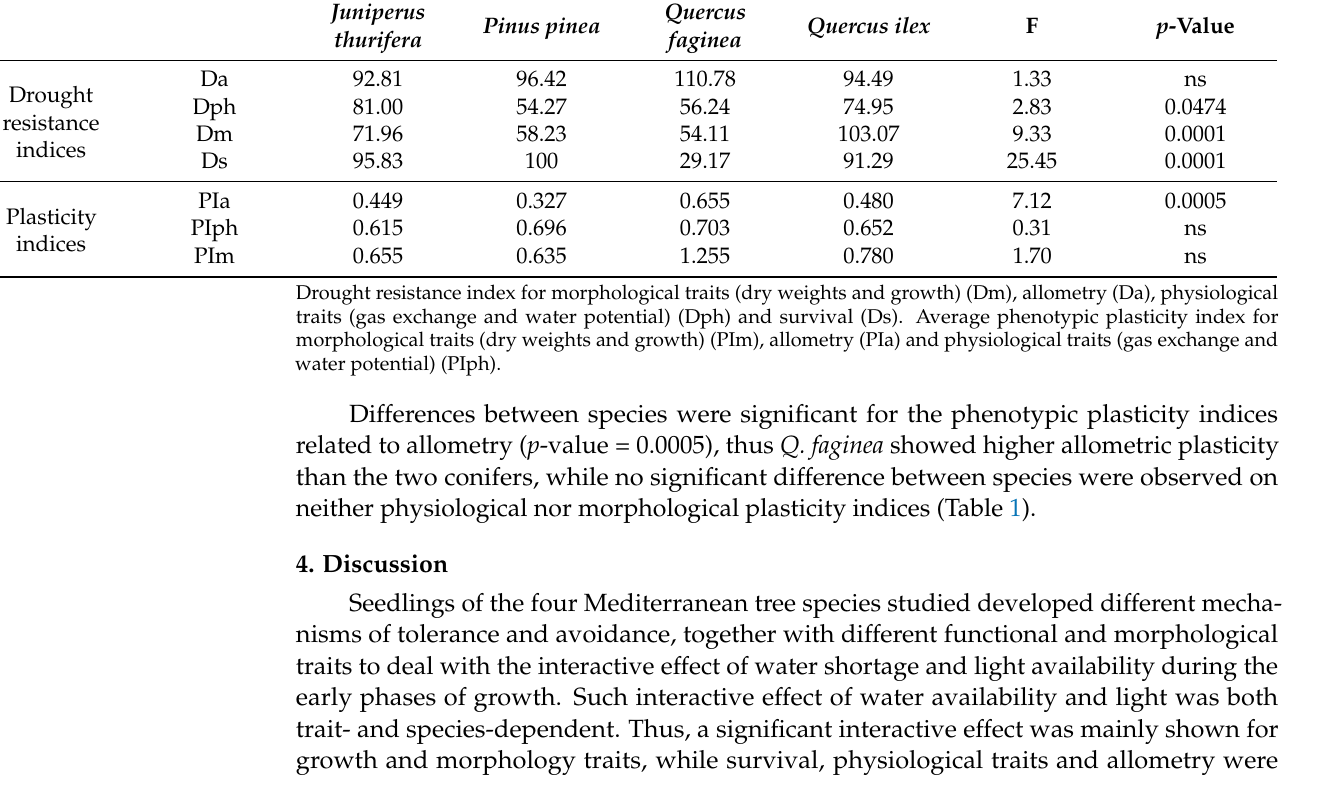
Table 1. Mean and ANOVA results (F-statistic value and probability levels) of the effect of species on drought resistance indices (Da, Dph, Dm and Ds) and plasticity indices.